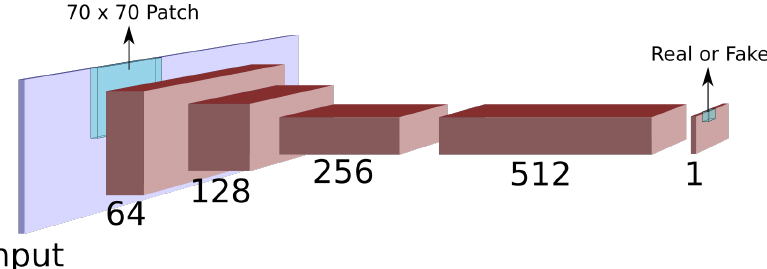
Figure 2. Diagram of the patch-based discriminator